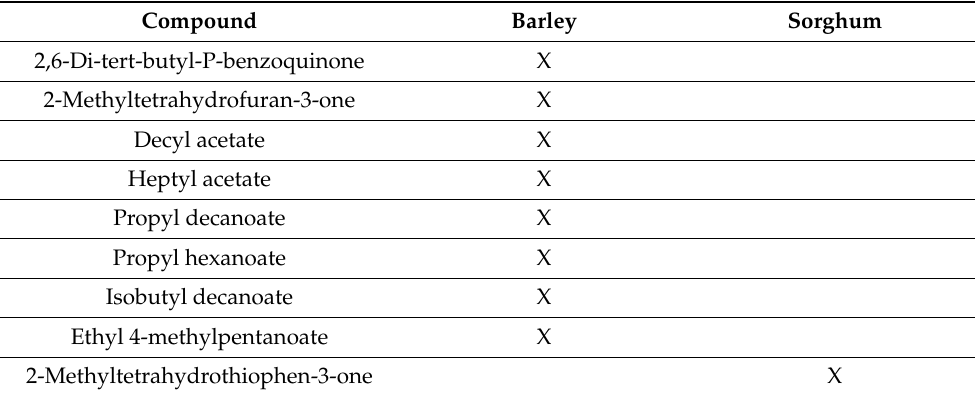
Table 2. Semi-volatile compounds were only observed in beers brewed from either barley or sorghum. Compound Barley